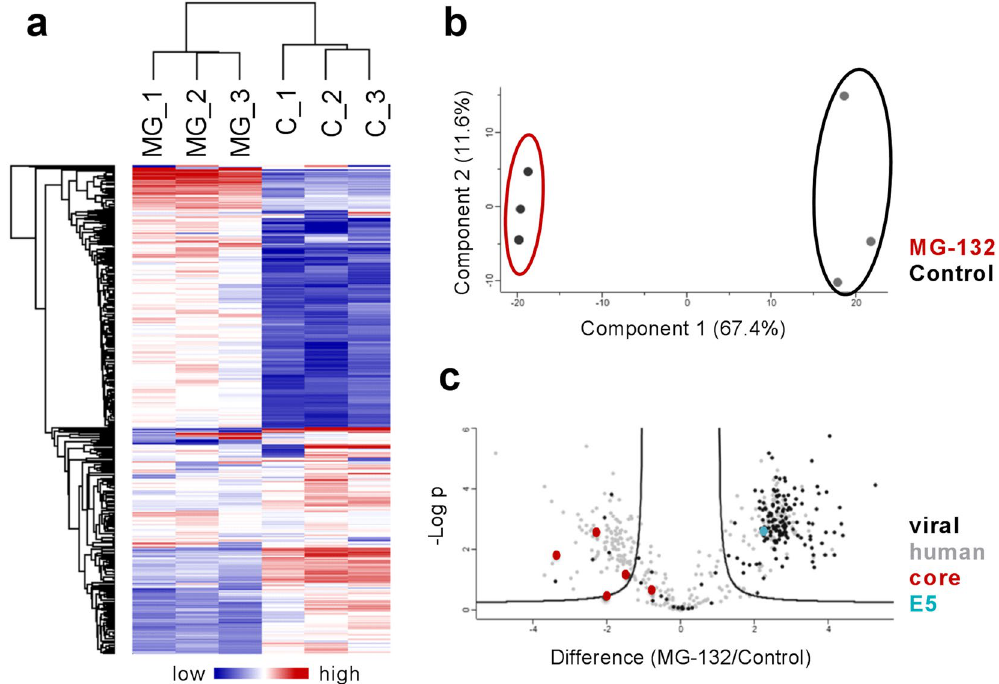
Figure 5. Proteasome-mediated degradation of ubiquitinated peptides at an early stage of CPXV infection. HeLa cells were infected in triplicate with CPXV BR at an MOI of 50 in the presence or absence of 10 µ M MG- 132. After 2 h post infection ubiquitinated peptides were analyzed by MS. Plots show normalized ubiquitinated peptide areas. ( a ) Cluster analysis reveals ubiquitinated peptides that are more abundant when the proteasome is inhibited (samples MG_1 to 3) compared to cells with non-inhibited proteasome (samples C_1 to 3), indicating their proteasomal degradation. ( b ) Inhibitor-treated samples (red) can clearly be separated from control samples (black) using principal component analysis. ( c ) Volcano plot showing significant differences (t-test, S0 = 2, permutation-based FDR 5%) in the amount of ubiquitinated peptides. Most viral peptides (black) are degraded in a proteasome-dependent manner but not major core proteins A11 and A4 (red). Instead, the uncoating factor E5 is proteasomally